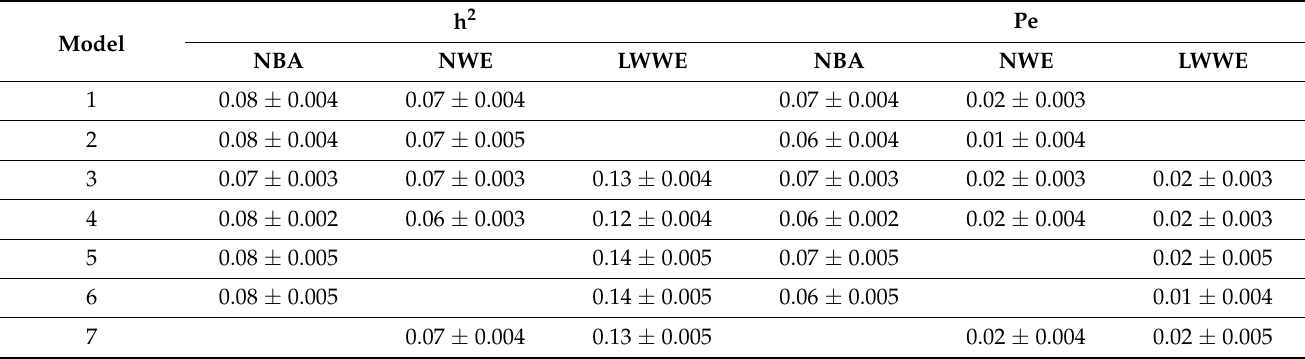
Table 5. Estimated heritabilities and maternal permanent effect of the examined